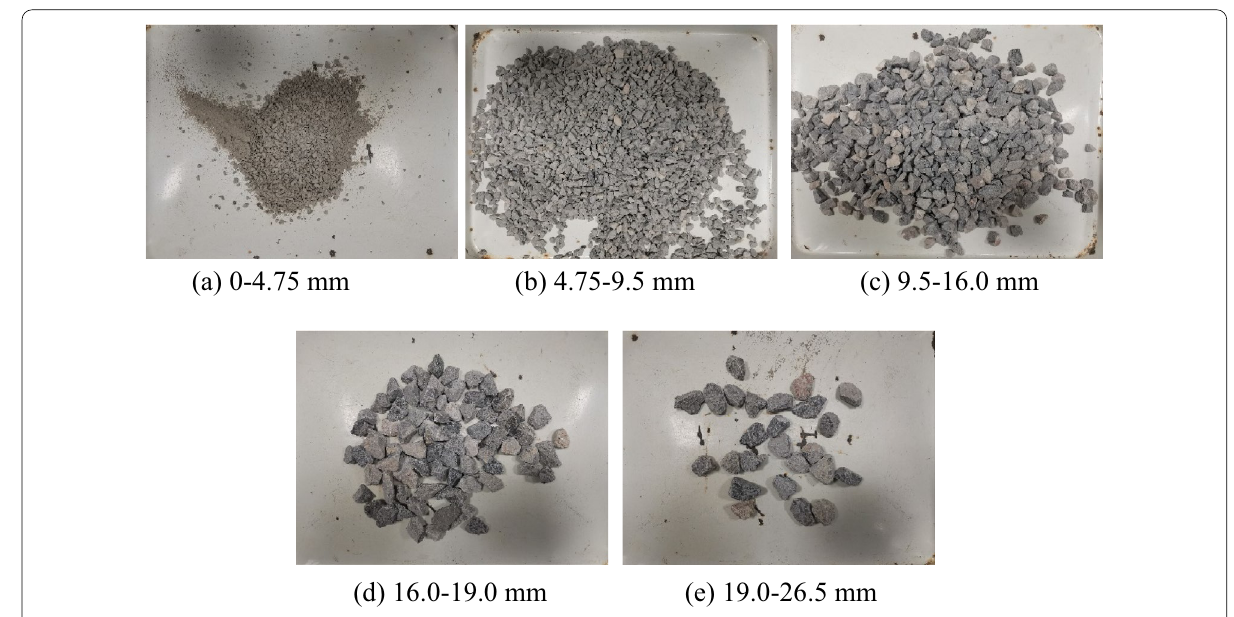
Fig. 3 Sieved fine and coarse aggregates with different diameters